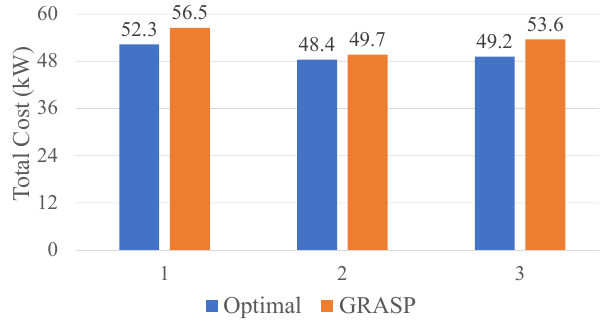
Figure 14. Comparison of power costs for the optimal solution and GRASP on the IEEE39 bus system.